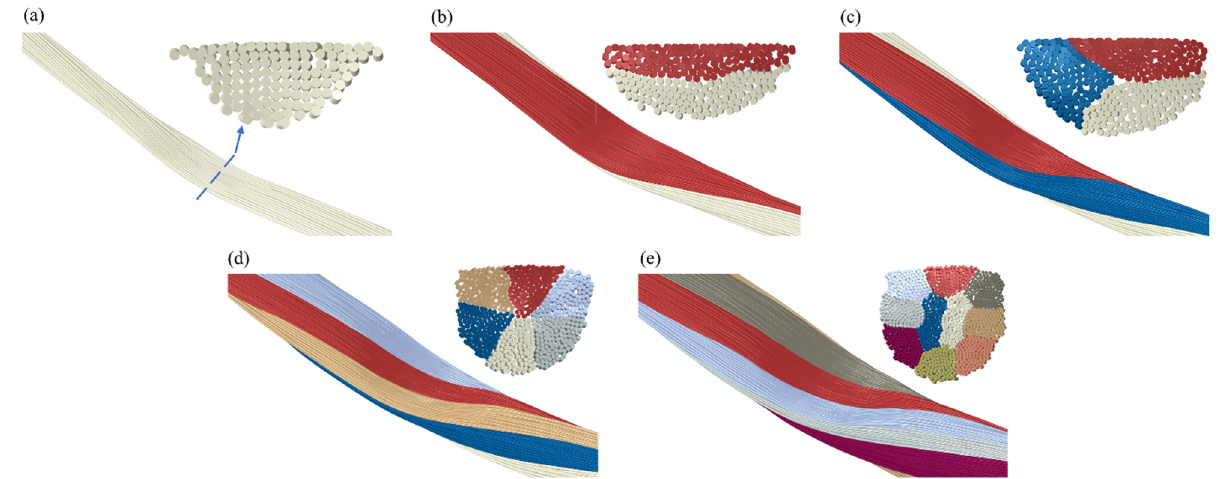
Figure 9. The prediction of the geometric model with the different number of plies: ( a ) 1 ply; ( b ) 2 plies; ( c ) 3 plies; ( d ) 6 plies; and ( e ) 10 plies.